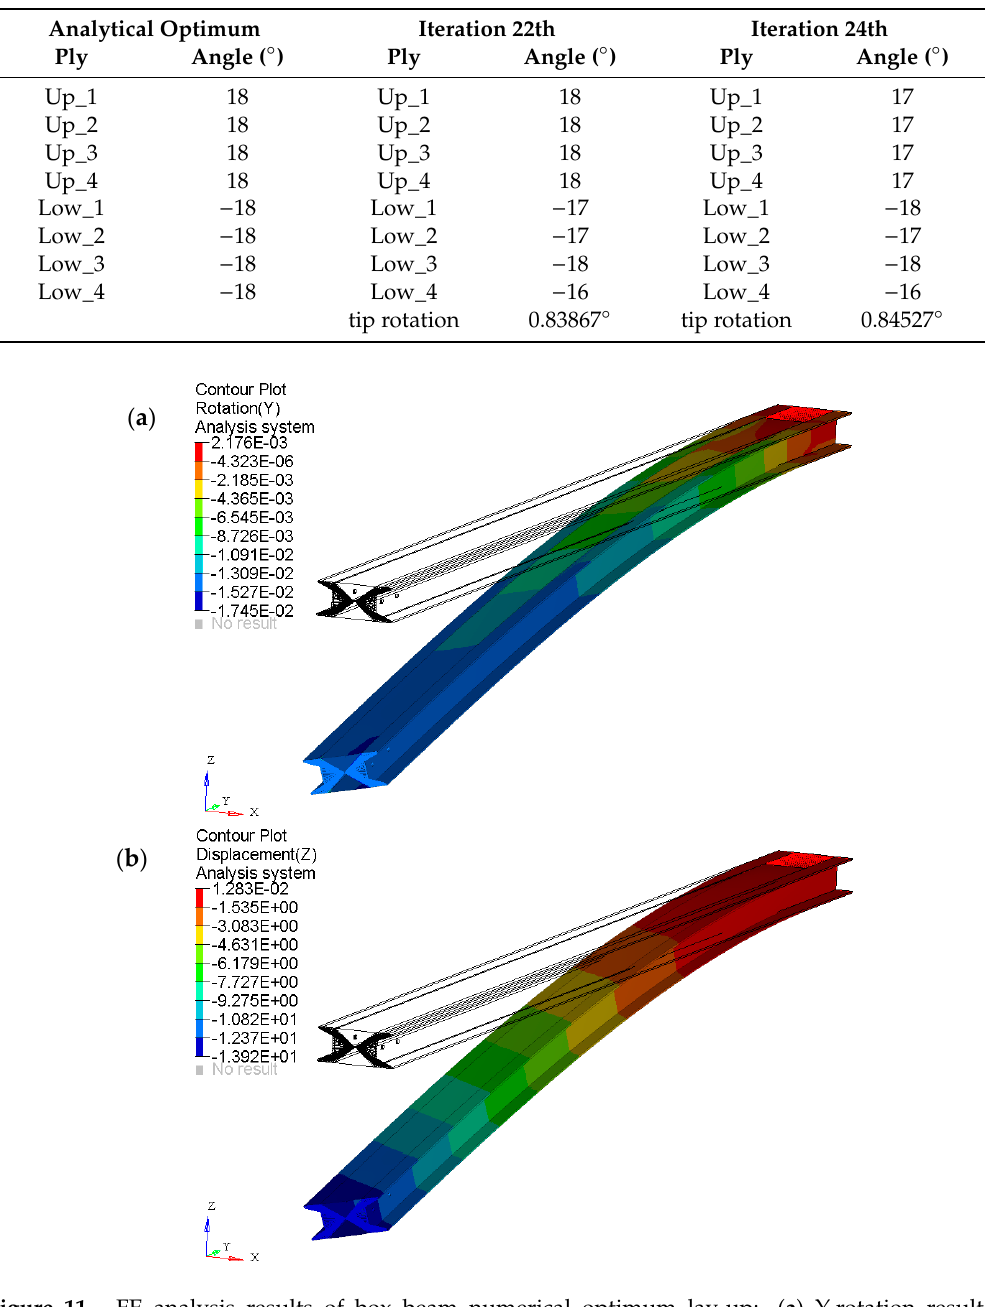
Figure 12. Graph with the angles ply iterative process. 5. Conclusions The validation of the optimal configuration for a hybrid isotropic/composite box-beam has been presented. The performances offered by the optimal beam configuration obtained with a low-fidelity beam model have been compared against those of a high-fidelity model synthesized using Altair OptiStruct and with an experiment. The selected structural performance expected by the low fidelity